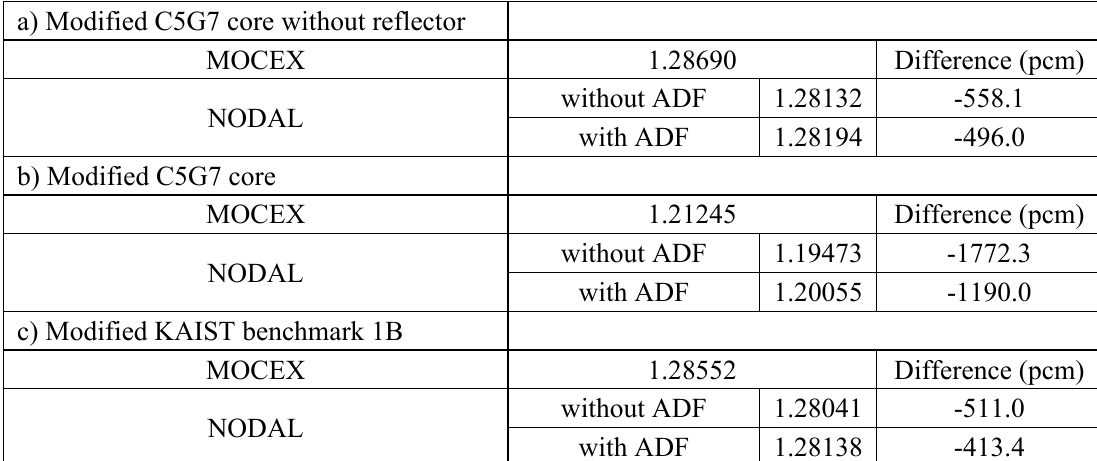
Table III. ADF Pprformance in k eff of NODAL solver